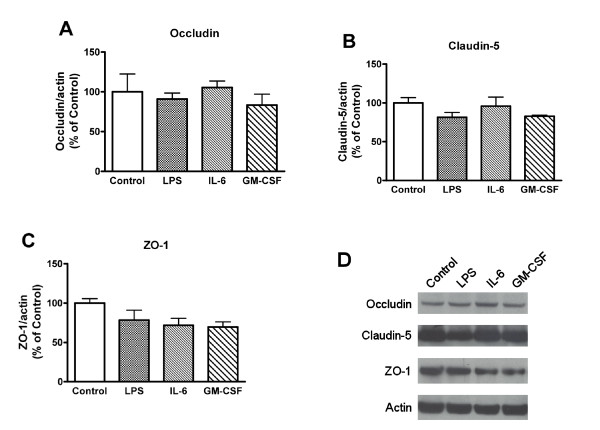
Effects of LPS, IL-6, and GM-CSF on the expression of tight junction proteins in BMECs. BMECs were exposed to LPS (100 μg/mL), IL-6 (100 ng/mL), or GM-CSF (100 ng/mL) for 4 hr. Expression levels of occludin, claudin-5, ZO-1, and actin were detected by western blot. Relative intensity of occludin (A), claudin-5 (B), and ZO-1 (C) is calculated as ratio of arbitrary densitometric units of target protein to that of actin. Results are expressed % of control. Values are means ± SEM (n = 3). (D) Photographs are representative in three independent experiments.